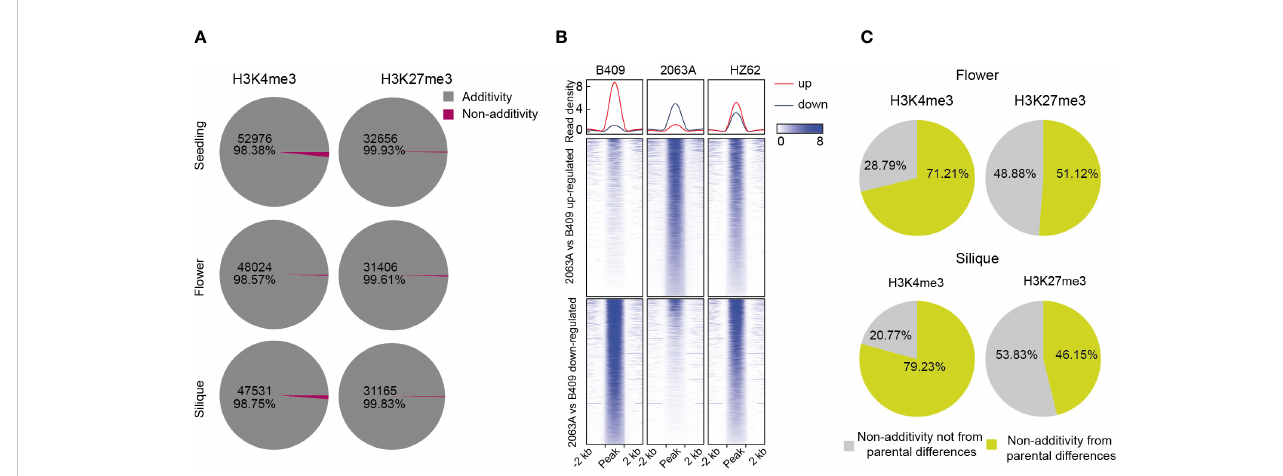
FIGURE 5 Overview of differentially histone-modi fi ed regions in hybrid compared with MPV. (A) Numbers of differentially histone-modi fi ed regions in the hybrid compared with MPV in seedling, fl ower bud and silique [FDR <0.05, log2 (fold change) > 1 or < -1]. (B) Comparison of intensities of H3K4me3 in differentially histone-modi fi ed regions among parents and hybrid. (C) Percentage of non-additively modi fi ed regions in hybrid originating from parental differentially histone-modi fi ed